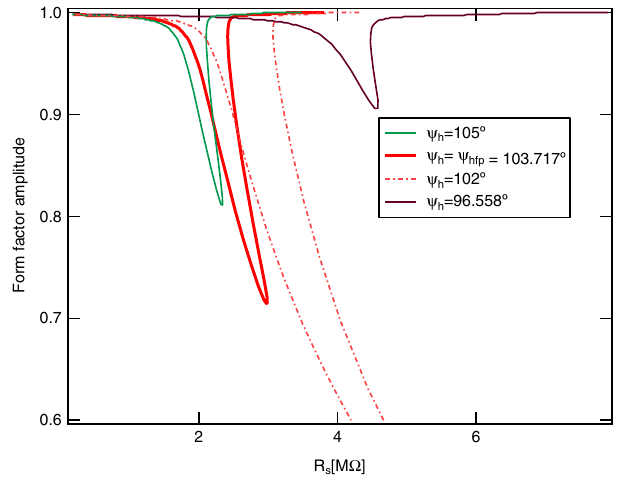
FIG. 16. Bunch form factor vs cavity shunt impedance for different values of harmonic cavity tuning